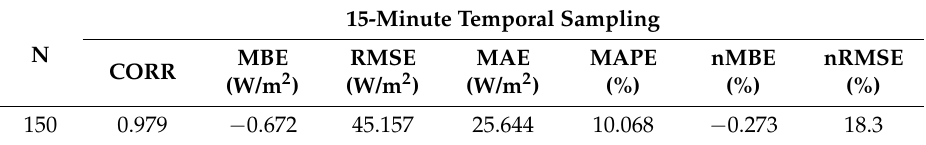
Table 6. Statistical analysis for the 15-minute AMESIS temporal sampling product against ground measurements at the IMAA/CNR—Tito site, considering the whole dataset. N = the total number of hourly mean irradiance values.